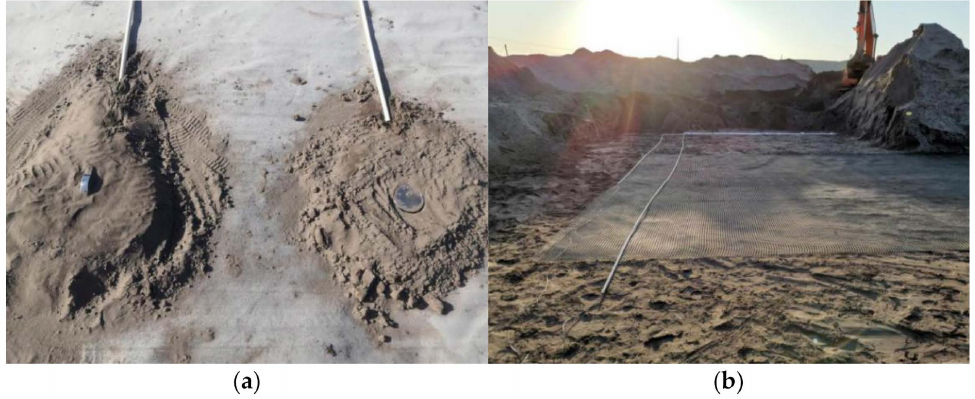
Figure 5. Sensor placement in the dam: ( a ) pressure box; ( b ) PWP